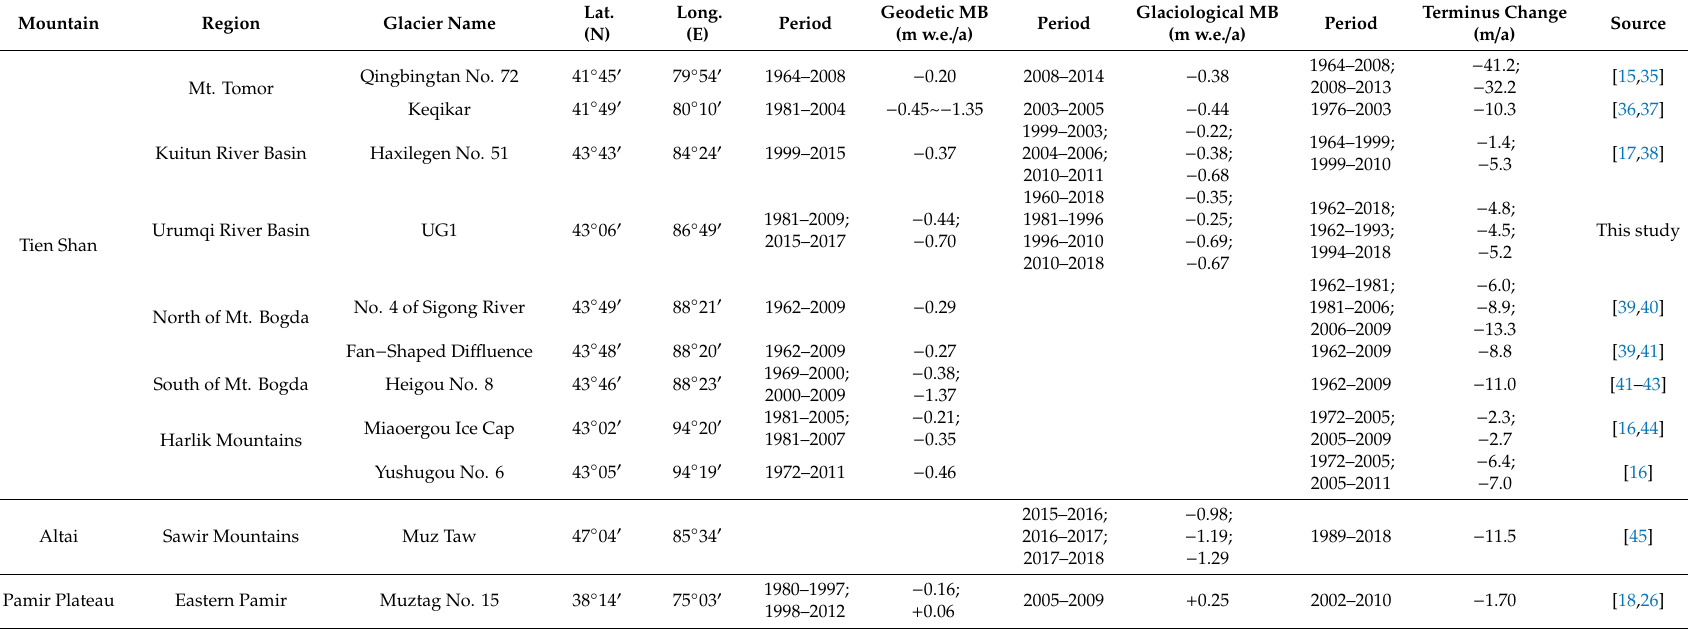
Table 1. Geodetic and glaciological mass balance (MB) and terminus changes of the in situ observed or field surveyed individual glaciers in Xinjiang. Mountain Region Glacier Name